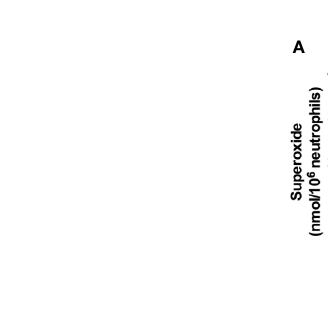
FIGURE 4 | Effects of mucin alone, and mucin with tobramycin on neutrophil superoxide release. (A) Neutrophils from healthy volunteers were stimulated with opsonized zymosan and superoxide release was determined by measuring the reduction of ferricytochrome c in the presence of cystic fi brosis airway mucin. (B) The cationic aminoglycoside, tobramycin was added to neutrophils stimulated with opsonized zymosan in the presence of 2 mg/ml of CFAM (white columns), and superoxide release was determined with ferricytochrome c . (n = 3, *p < 0.05, ***p < 0.001, ****p < 0.0001 vs.